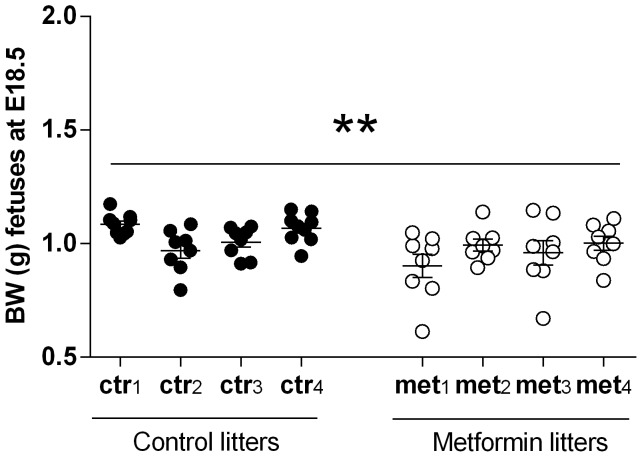
Weight of the fetuses (E18.5).Body weight of litters at E18.5; ctr1-4 denotes prenatal control litters and met1-4 prenatal metformin litters, Litter size 8–9. ** = P<0.01 by Mann-Whitney test when individual fetal weights are tested (pooled results from two separate studies).